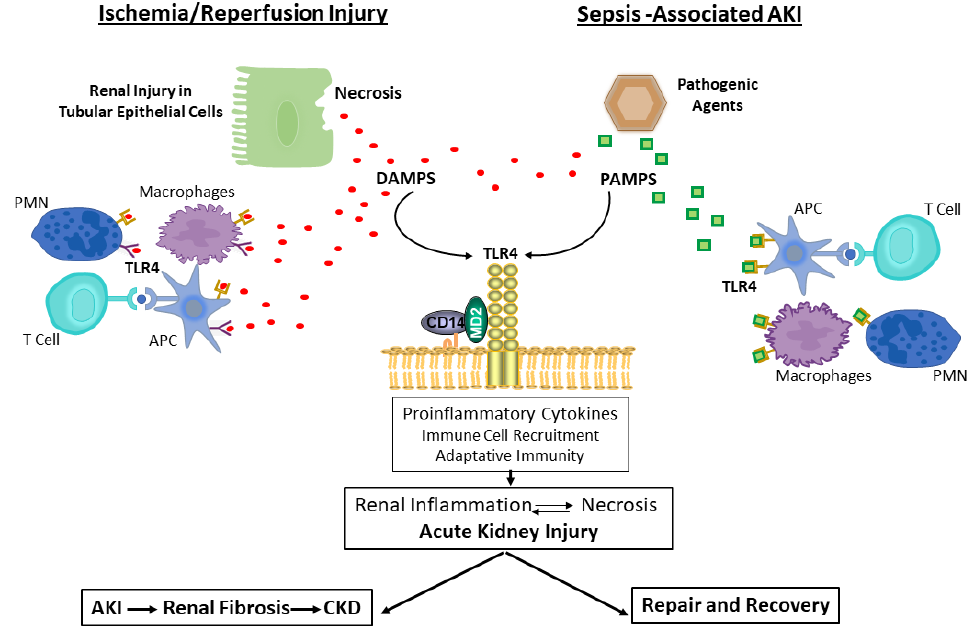
Figure 4. Role of TLR4 in the cycle of renal injury. Abbreviations: DAMPs, danger-associated molecular patterns; PAMs, pathogen-associated molecular patterns; APC, antigen-presenting cells; AKI, acute kidney injury; CKD, chronic kidney disease.